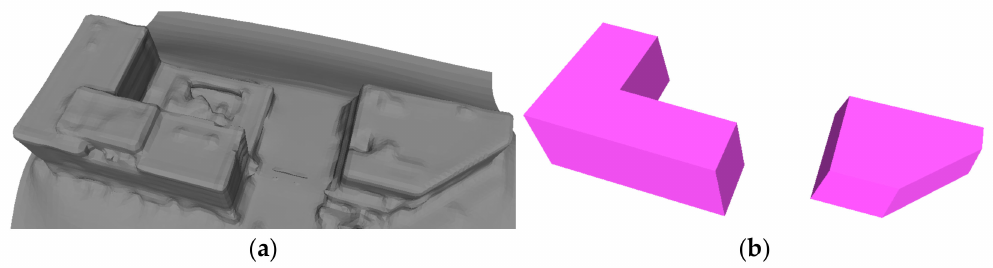
Figure 16. Mesh model with a lower fineness ( a ) and its simplification result ( b